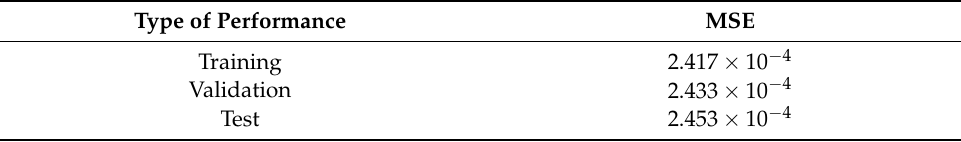
Table 2. Performances for Case A.